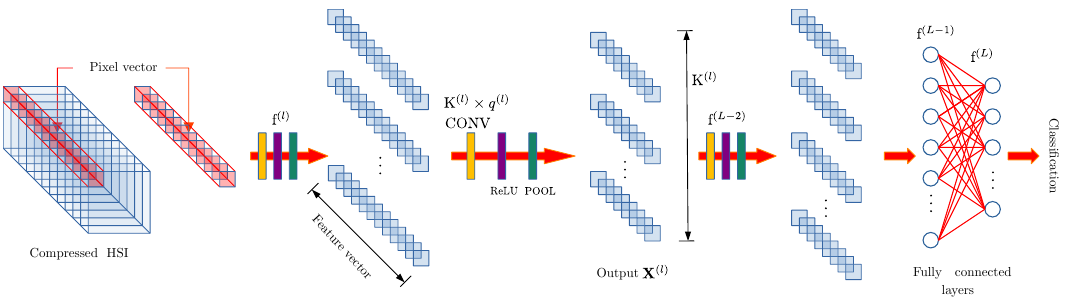
Figure 3. Traditional architecture of spectral convolutional model employed using 1DCNN [2]. Spatial DL models (2DCNN) consider the spatial information obtained from the neighbor pixels of the HSI, see Figure 4. For that reason, the input will be spatial patches of d × d pixels cropped from the complete HSI with the pixel of interest at the center. To extract spatial features, on each CONV layer, 2D-kernels are applied over the input data, such that K ( l ) × k ( l ) × q ( l ) , obtaining K ( l ) feature maps as a result [2].